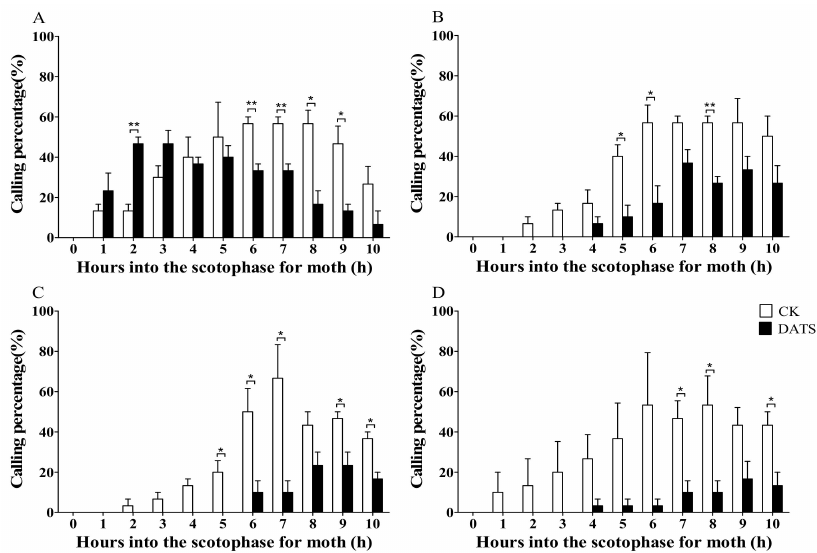
Figure 4. E ff ects of diallyl trisulfide (DATS) on the calling periodicity of Sitotroga cerealella on ( A ) day 1, ( B ) day 2, ( C ) day 3, and ( D ) day 4. Error bars indicate SEM. Asterisks indicate significant di ff erences at * p < 0.05 and ** p < 0.01 ( t -test). CK is the control group.